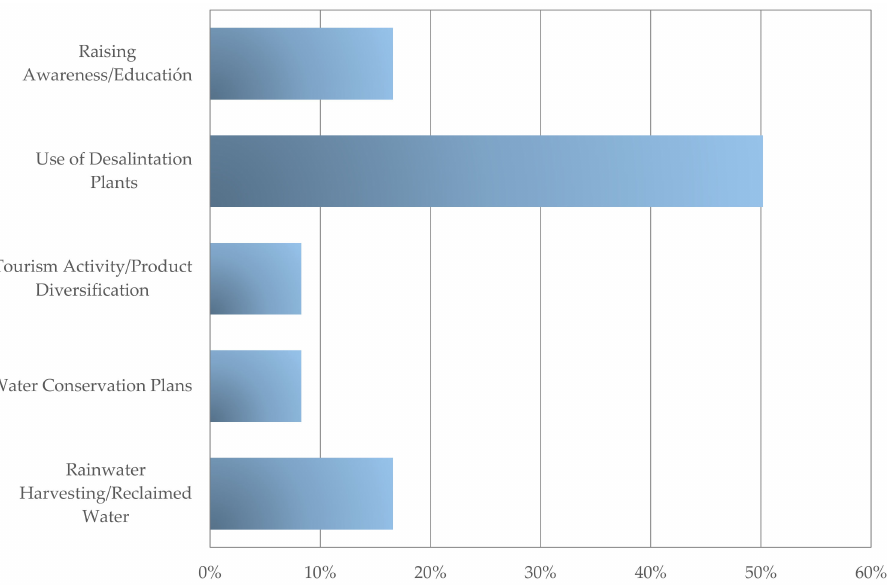
Figure 5. Respondents’ Perceptions: the most important adaptation strategies to tackle the impacts of climate change